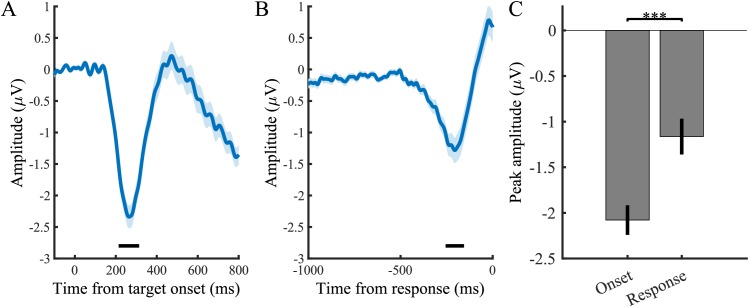
N2c amplitude is reduced when aligned to the response.(A) N2c signal aligned to target onset. (B) N2c signal aligned to response. (C) N2c amplitude over a 100 ms window (black bars in A and B) aligned to target onset and response. Error bars denote ±1 standard error of the mean (SEM). Stats, Wilcoxon signed rank test.